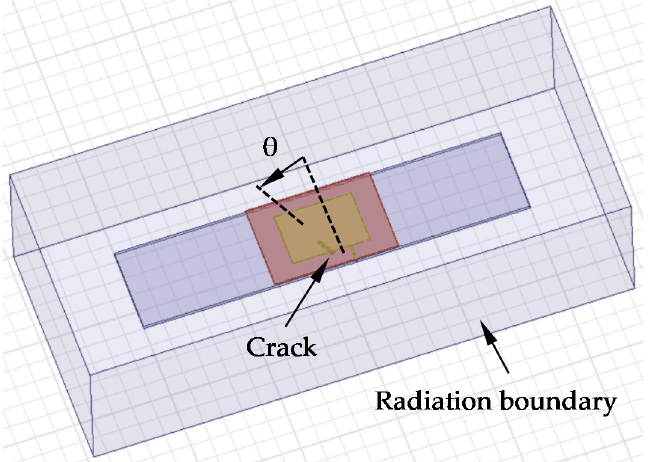
Figure 7. Simulation model for crack orientation